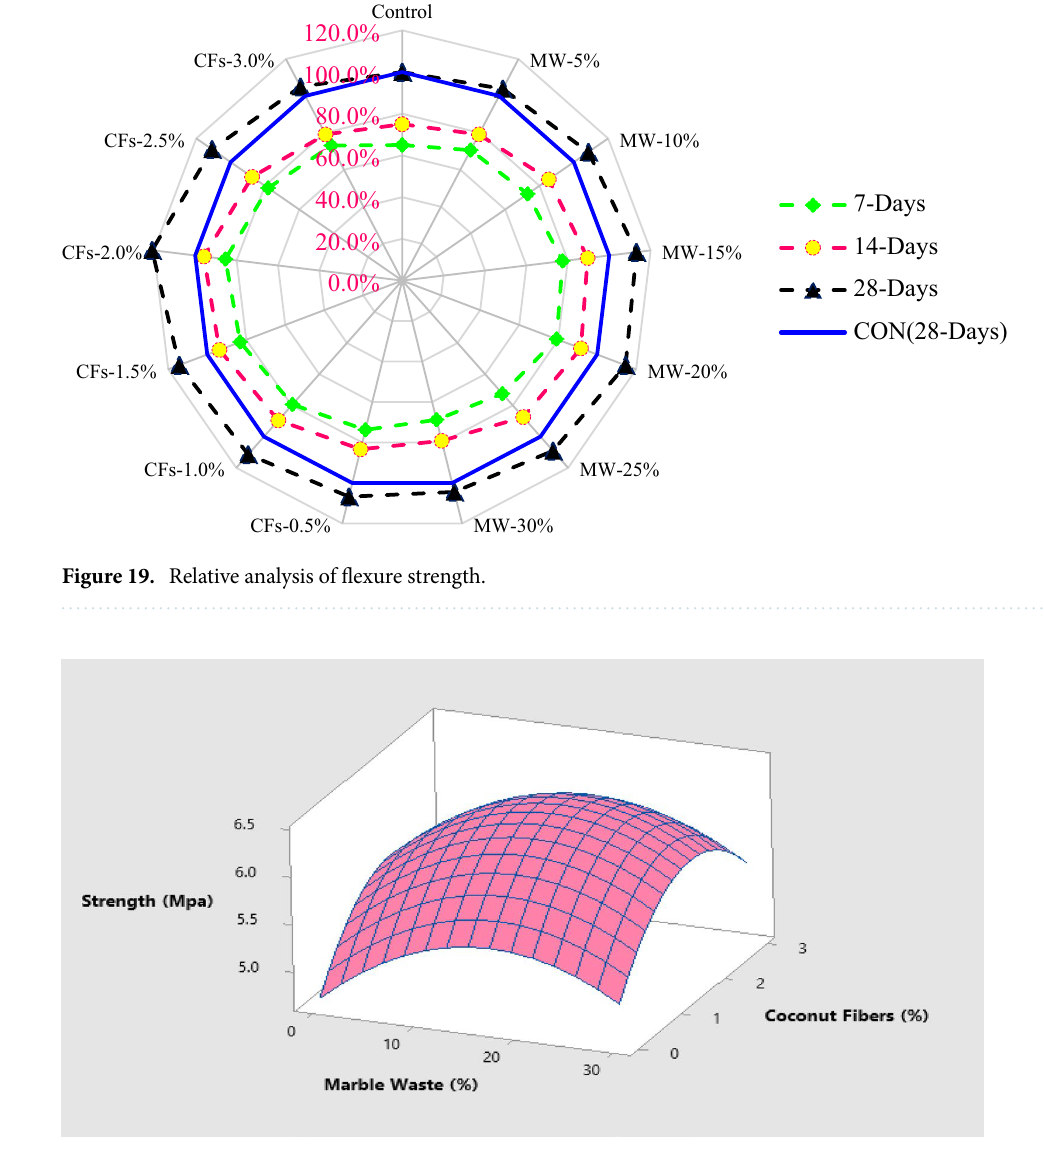
Figure 20. 3D response surface for flexure